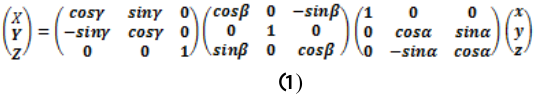
Down Deformation Up Deformation Figure 5. Representation of Horizontal Deformation and Vertical Deformation